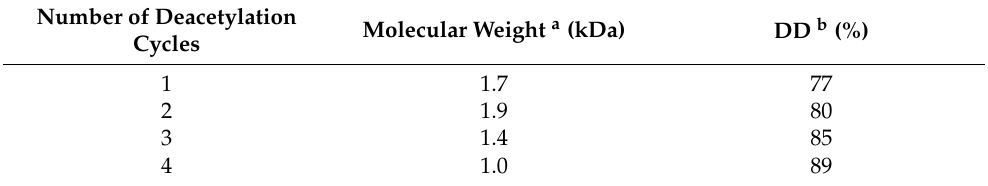
Table 5. Characteristics of the chitosan samples prepared in-house by chitin deacetylation.